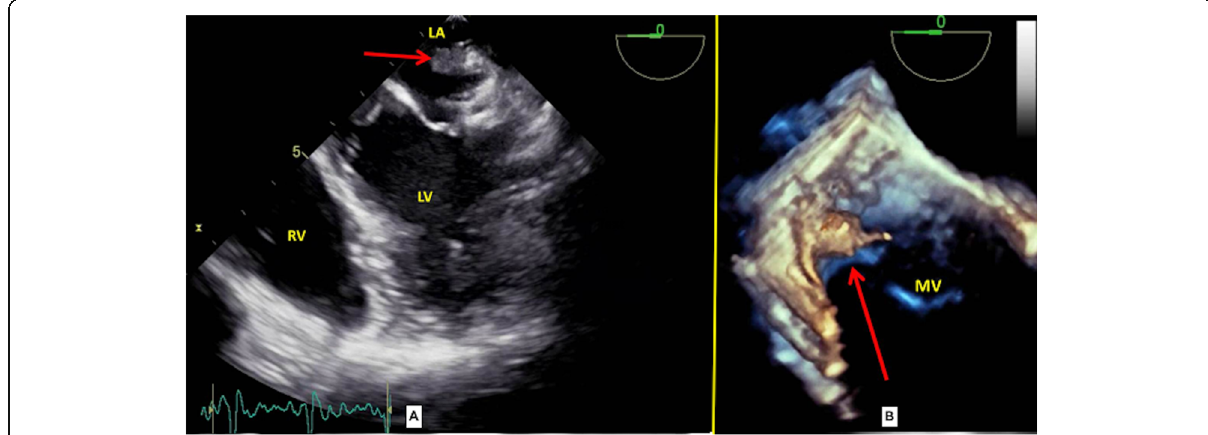
Fig. 2 Intra-operative trans-oesophageal echocardiography — A vegetation in the left atrium (red arrow) away from the mitral valve and B 3D reconstructed image of the same showing the vegetation (red